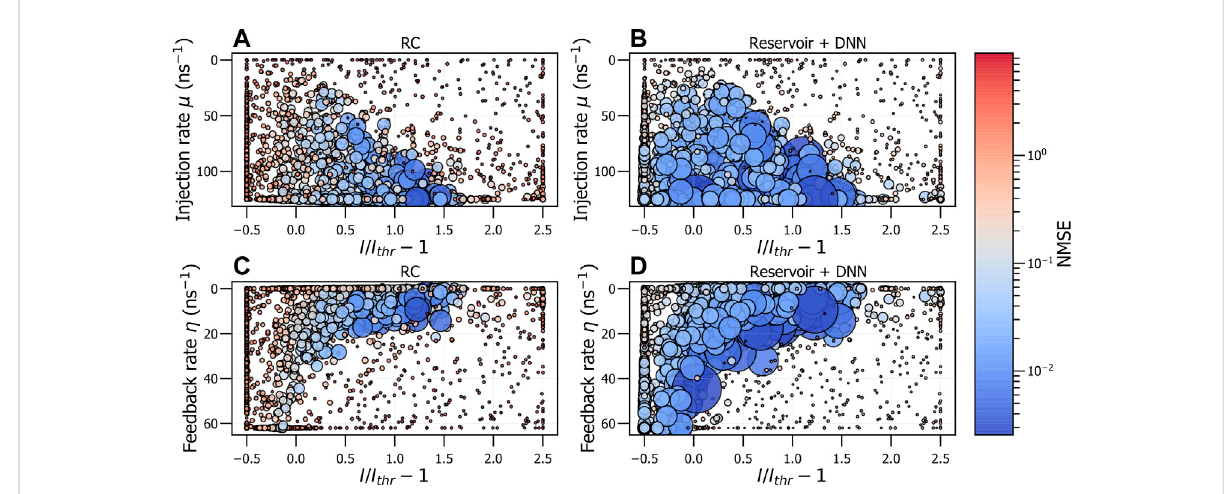
FIGURE 5 NMSE for various values for injected pump current, feedback rate and injection rate. The selection of these values was performed using a Bayesian optimisation of this three dimensional parameter space. The two leftplotsare theresults when using only an RC system, (A,C) , and the two rightplotsaretheresultsofthereservoircombinedwiththeDNN(trainedfor1.6×10 4 epochs), (B,D) .Largeandbluevaluesforthedotsindicatealow NMSE, and thus a good performance.